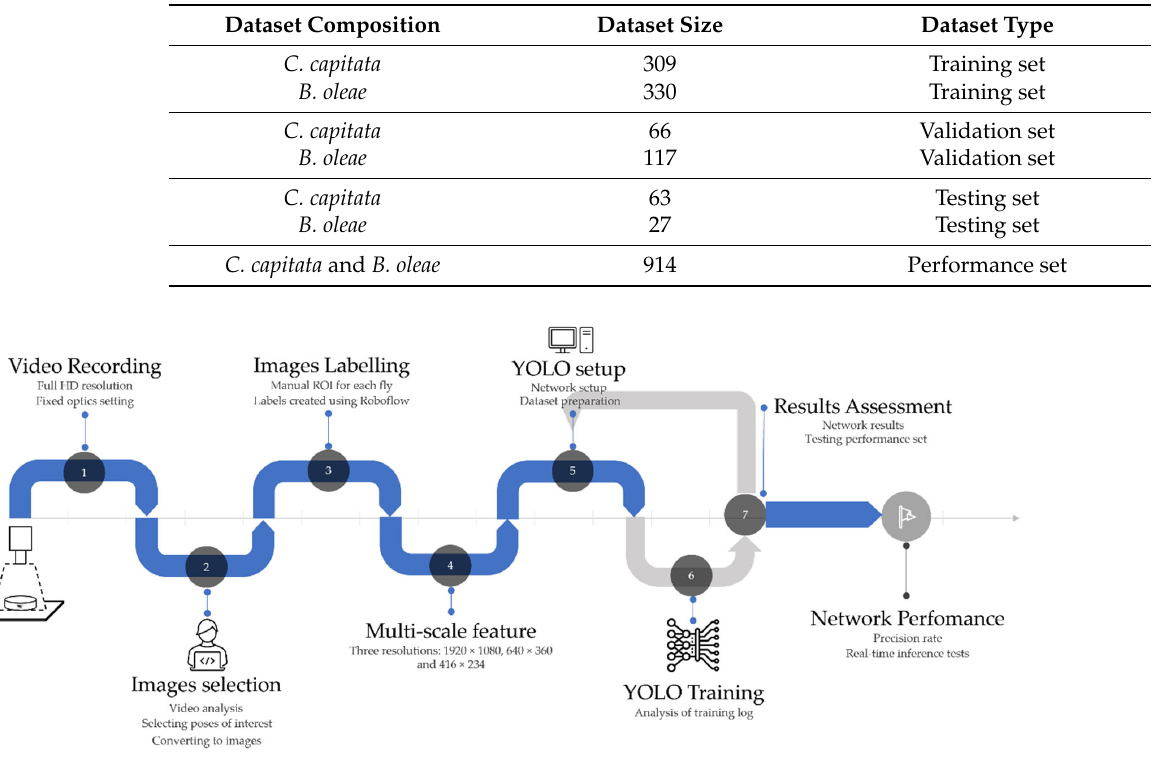
Figure 3. A schematic representation of the developed steps from data capturing (1) and data pre